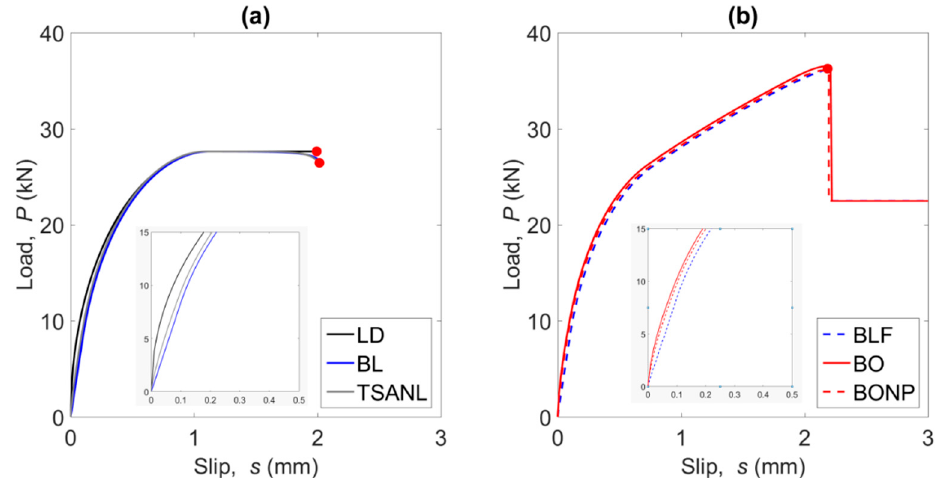
Figure 7. Comparison of the load–slip curves, ( a ) shows LD, BL and TSANL models, and ( b ) shows BLF, BO, and BONP models.